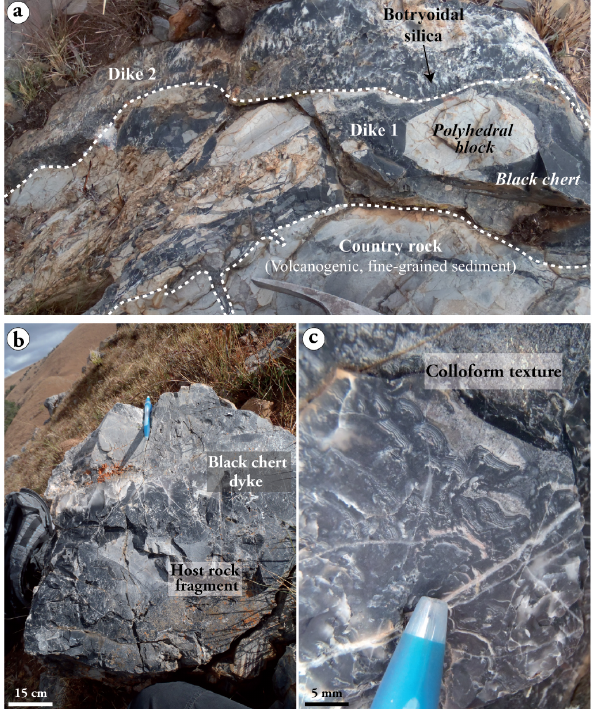
Figure 5. Examples of homogeneous dikes where host rock frag- ments are rare or absent. The silica precipitated to form either botry- oidal columnar structures perpendicular to the fracture wall (a) , or colloform structures alternating thin black-and-white laminations (b, c)